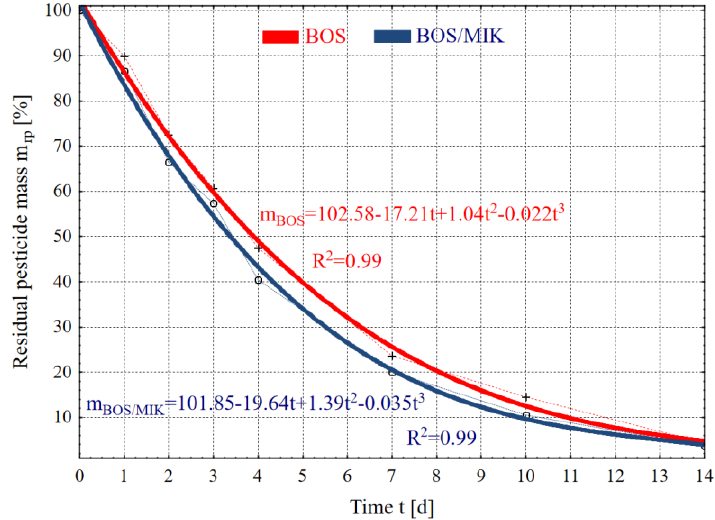
Figure 4. Mass deposition (% residual BOS mass) in wastewater without microorganisms (BOS) and enriched with microorganisms (BOS/MIK) passed through a constructed wetland bed at 14 days.